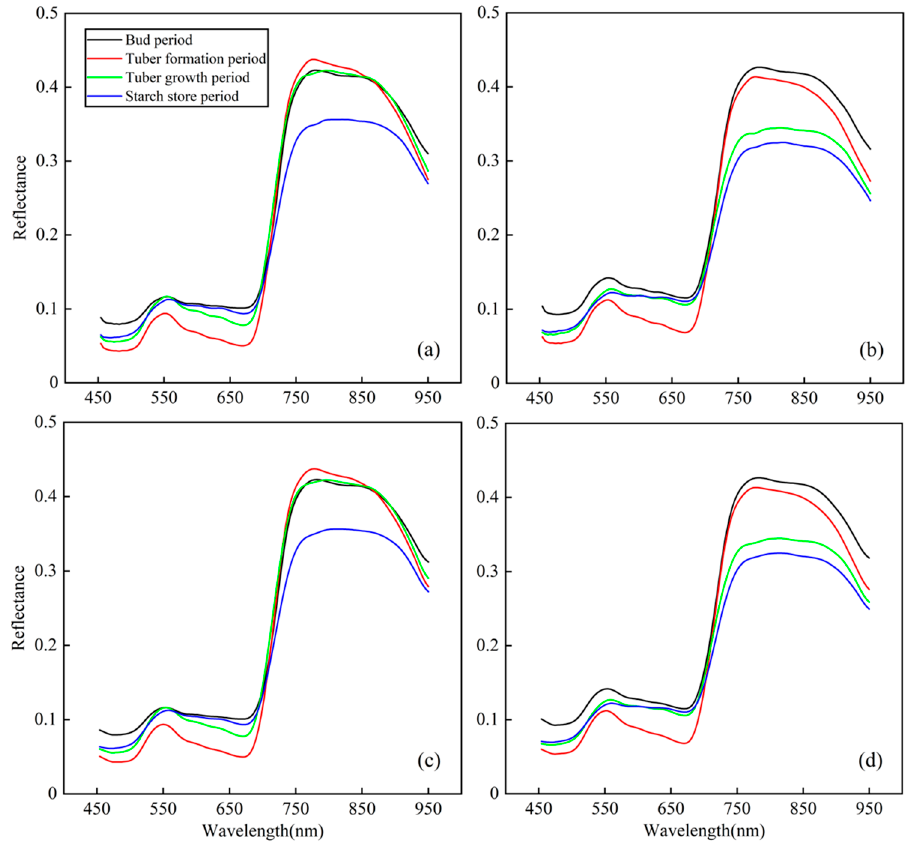
Figure 2. Canopy spectral-reflectance curves of potatoes in each growth period before and after SG filtering: ( a , c ) Z5 potatoes, ( b , d ) Z3 potatoes. filtering: ( a , c ) Z5 potatoes, ( b , d ) Z3